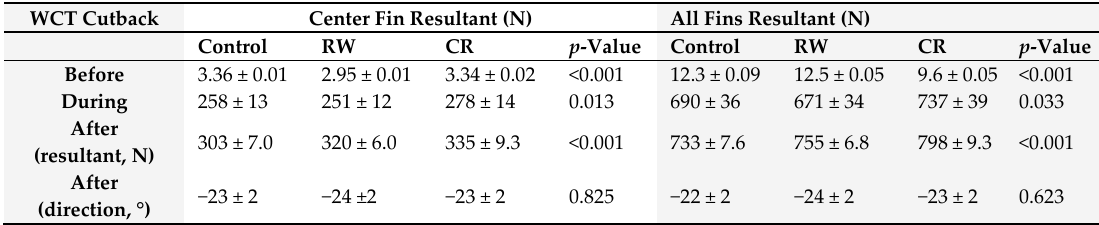
Table 1. Mean resultants, 101 data points each, for before (0.022 to 0.222 s), during (0.3 to 0.5 s)